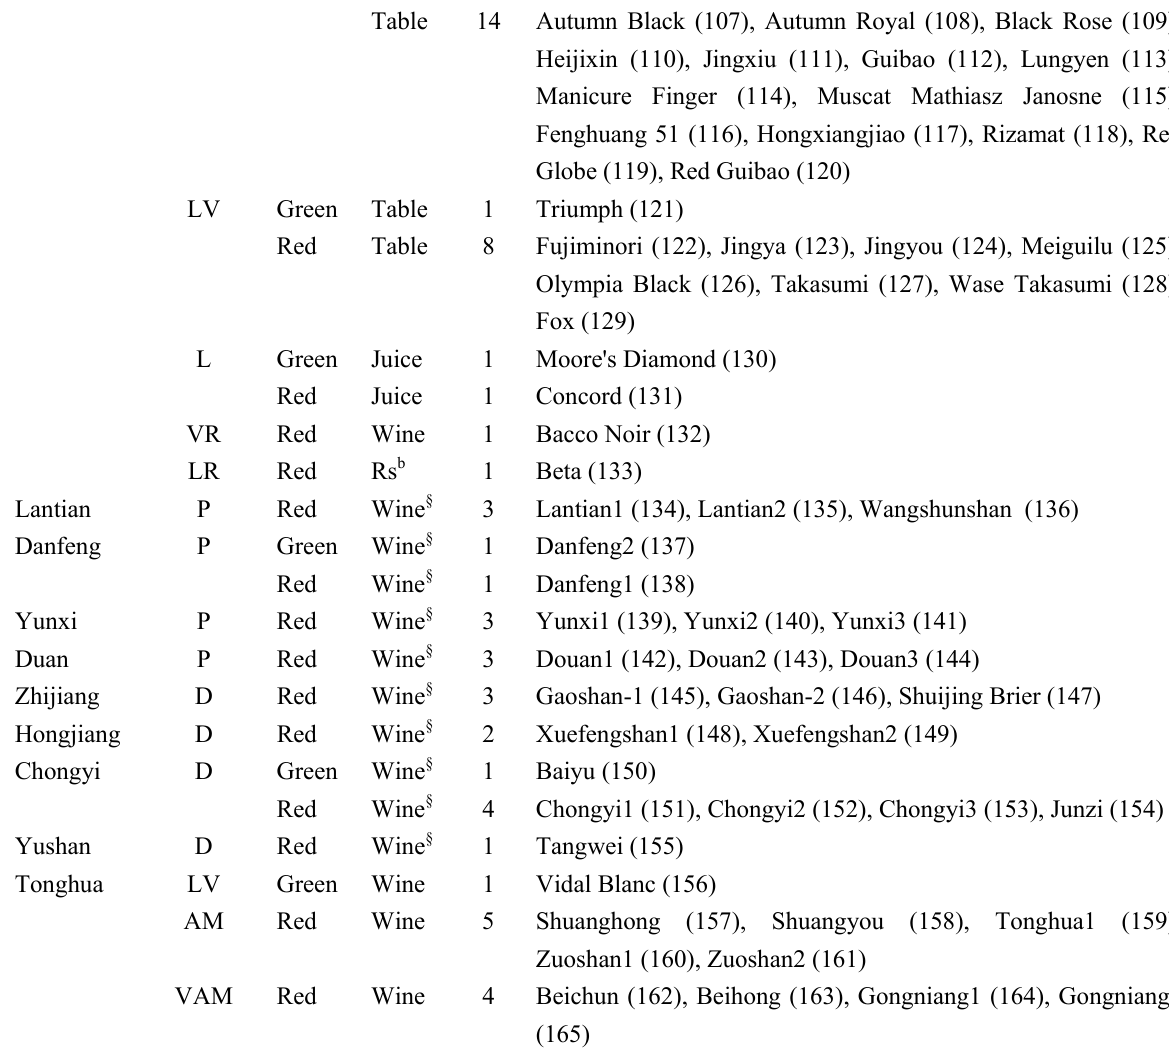
14 Autumn Black (107), Autumn Royal (108), Black Rose (109), Heijixin (110), Jingxiu (111), Guibao (112), Lungyen (113), Manicure Finger (114), Muscat Mathiasz Janosne (115),